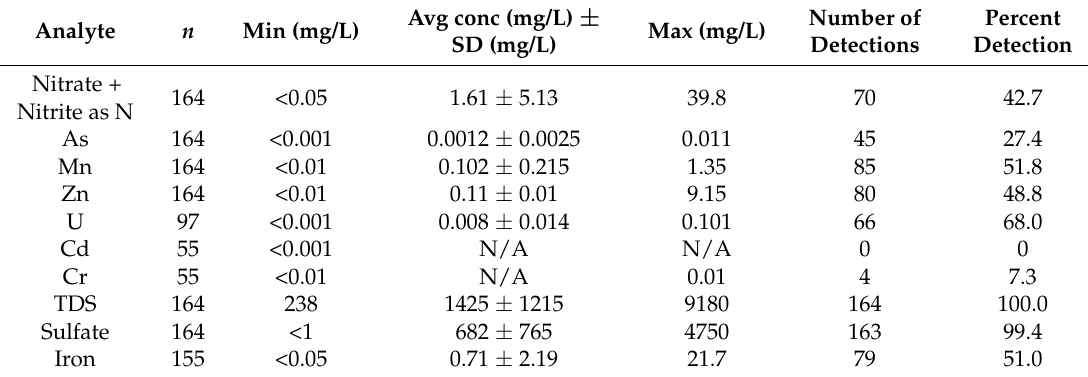
Table 3. Statistics for well water